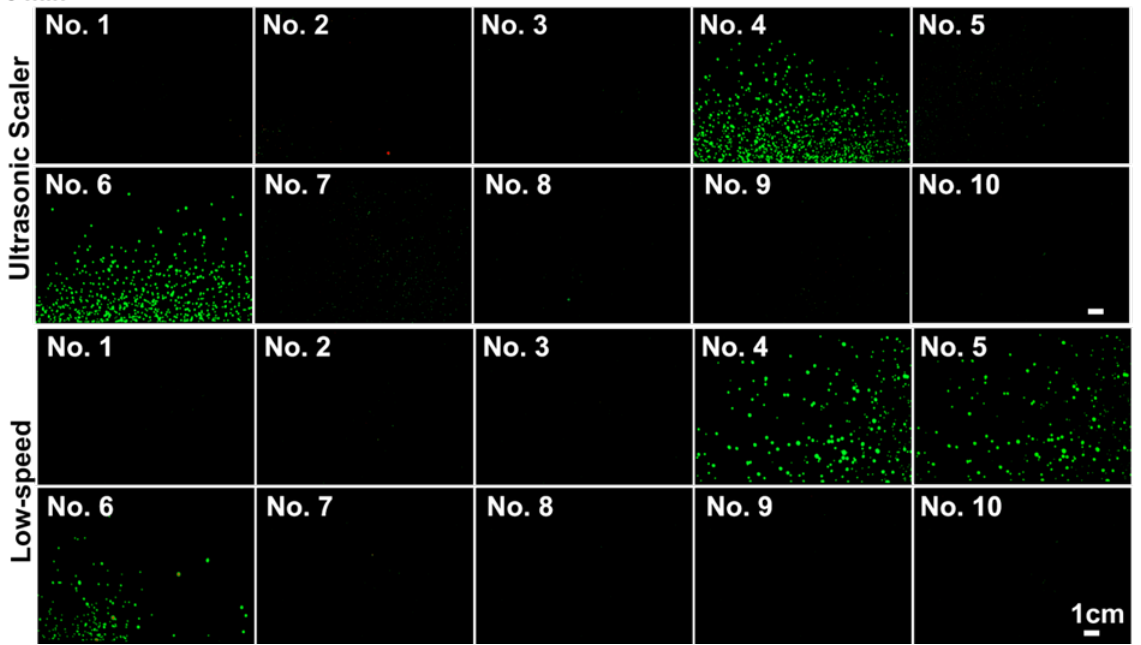
Figure 4. The splatter pattern by ultrasonic scaler and low-speed handpiece after 5 min surgeries.